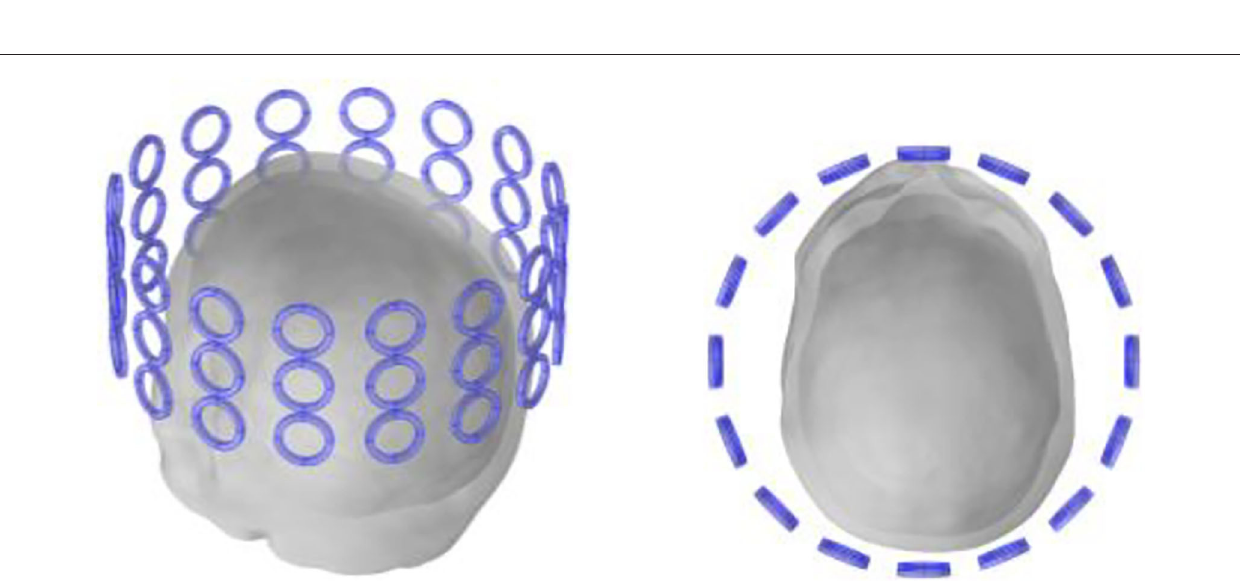
FIGURE 4 | Detection